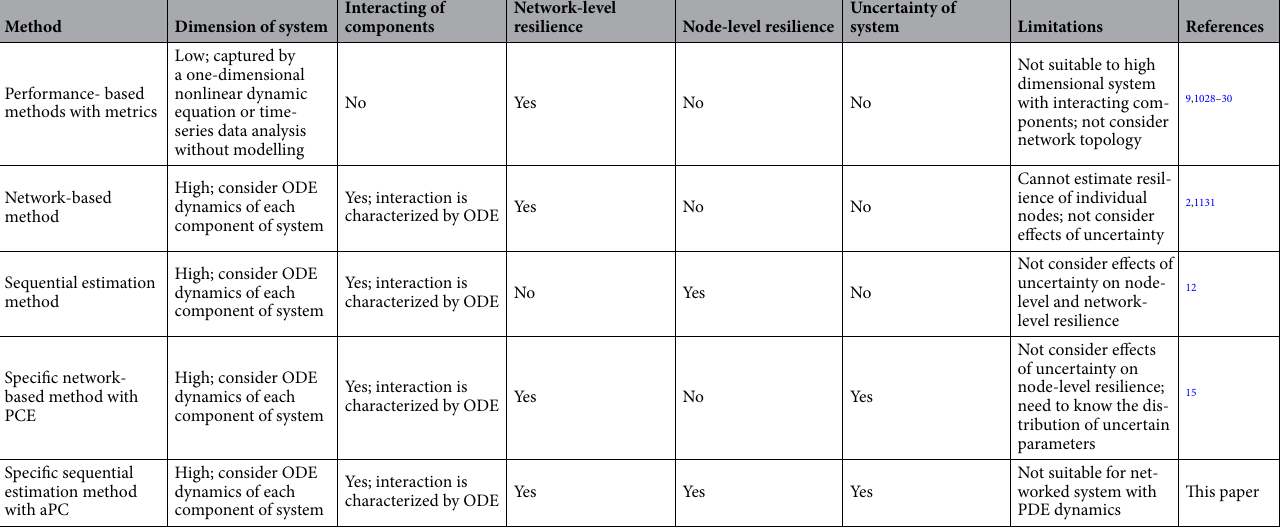
Table 1. Methods to analyze resilience of